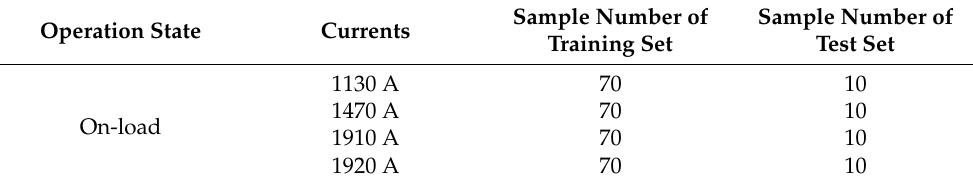
Table 5. Samples in the on-load